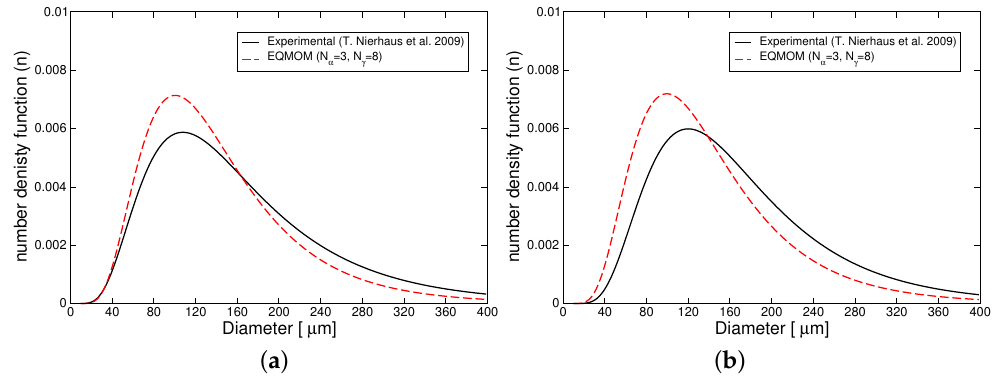
Figure 10. Bubble size distribution in W1 for ( a ) EQMOM (three nodes) and rpm = 100; ( b ) EQMOM (three nodes) and rpm = 250.